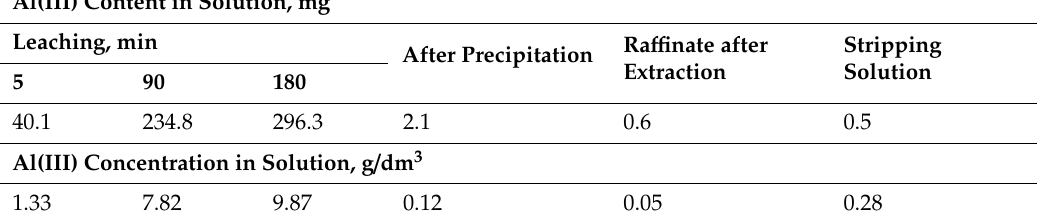
Table 6. Al(III) content in four-step process: leaching-precipitation-extraction-stripping (leaching solution: 0.5 M H 2 SO 4 at 95 ◦ C).